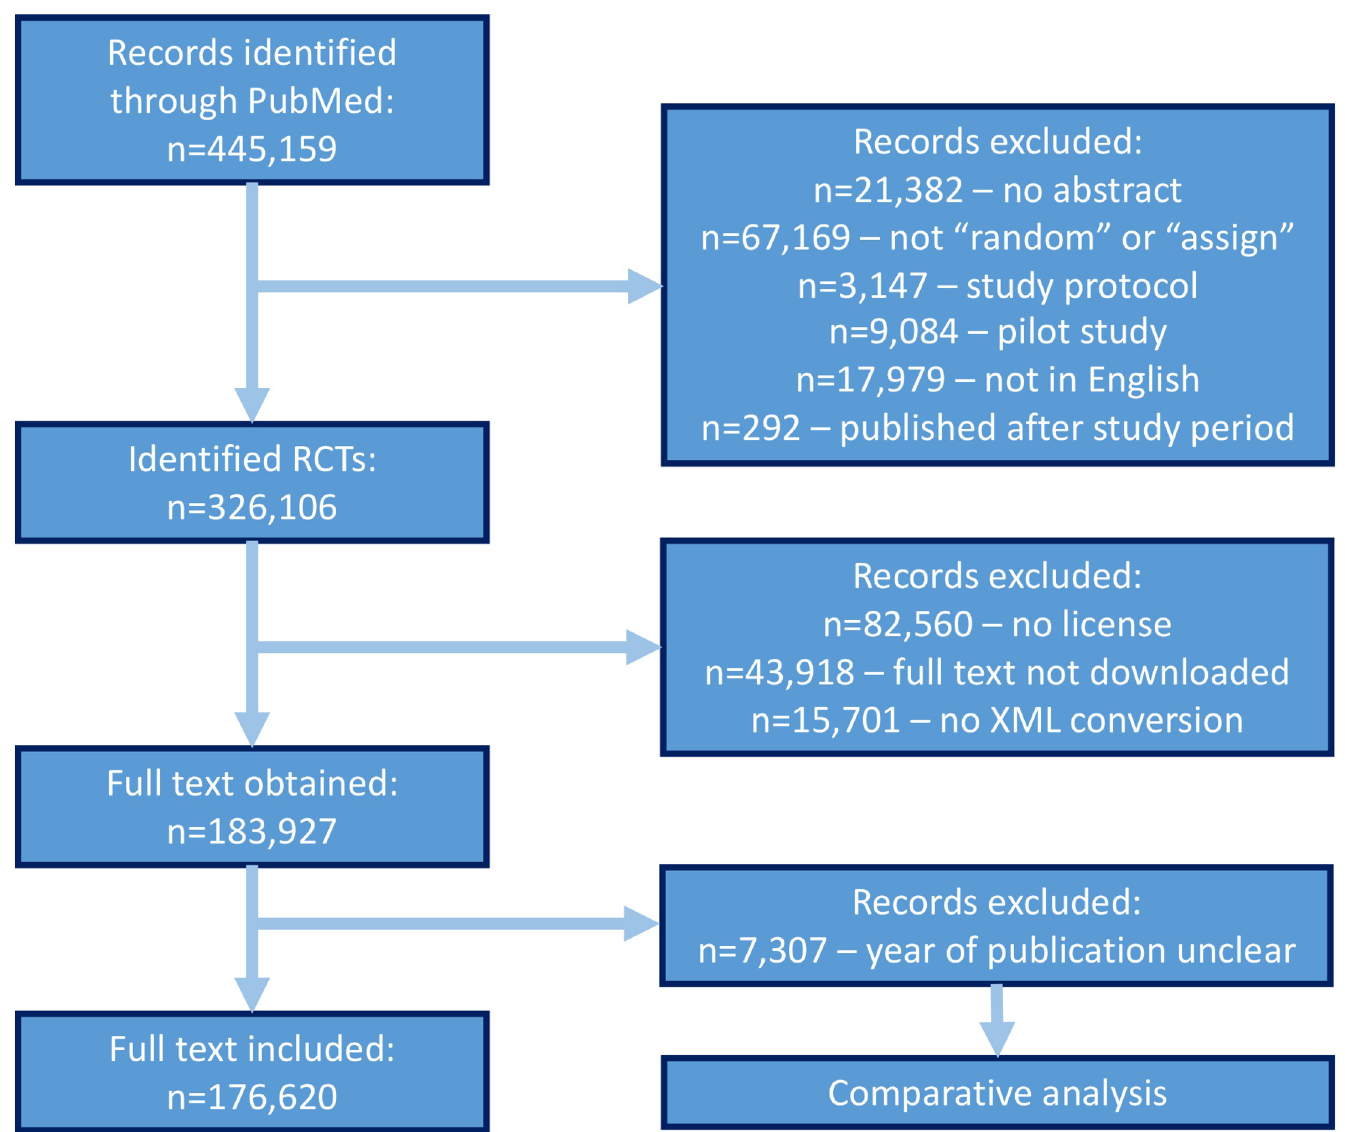
Fig 1. Flowchart AU : PleasenotethatdoublequotationmarkshavebeenusedthroughoutthepapertoadheretoPLOSstyle : Forconsistency ; pleaseprovideanupdatedFig 1 filewiththesinglequotationmarksreplacedwithdoublequotationmarks : of how the final full-text randomized clinical trials were obtained. 1. R AU : AbbreviationlistshavebeencompiledforthoseusedthroughoutFigs 1 (cid:0) 4 andTable 1 : Pleaseverifythatallentriesarecorrect : CT, randomized controlled trial.